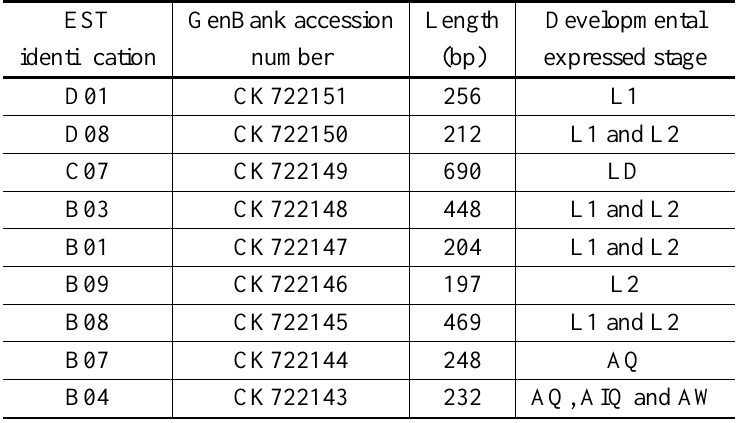
Summary of information about the nine Melipona scutellaris ESTs differen- tially expressed. ESTs B03 and B04 show significant similarity with Apis mel- lifera genome version 2.0, using Blast N algorithms. Developmental